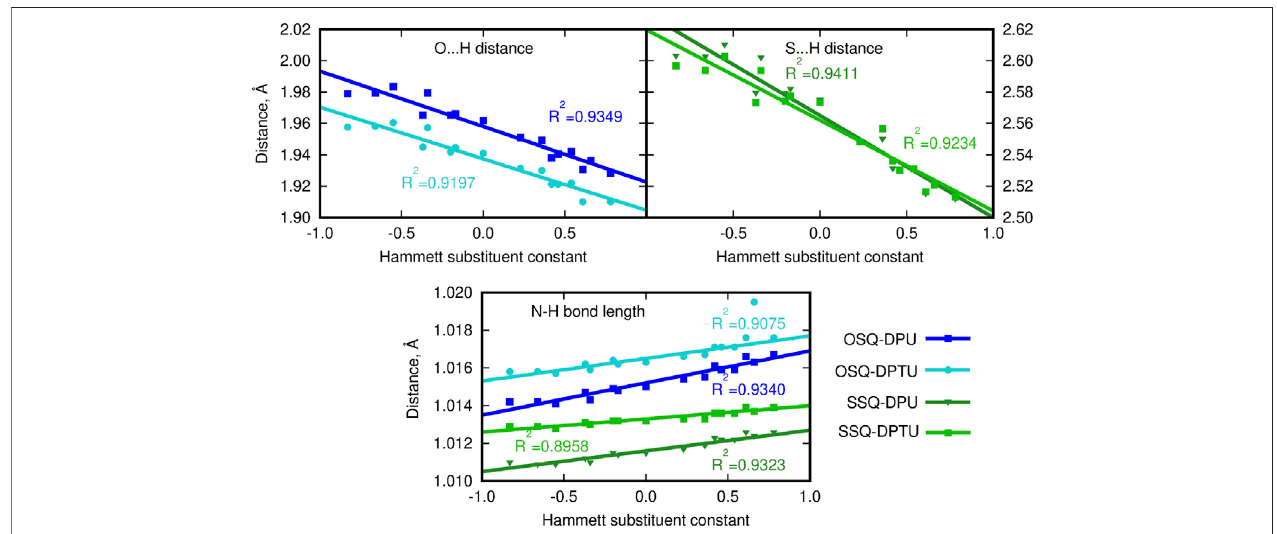
FIGURE4| Geometricalparametersforhydrogenbonds(A ... HandD –